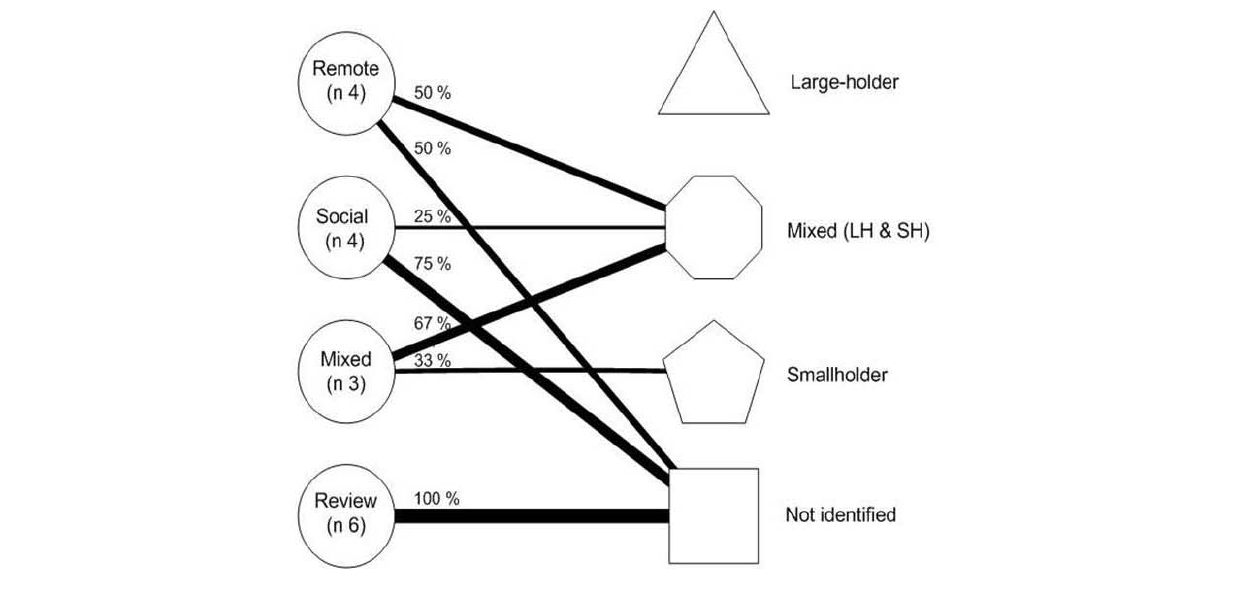
Fig. 5. Actor focus of the different research approaches, using studies from Indonesia. The thickness of the lines linking the shapes represent the percentage of studies focusing on each actor